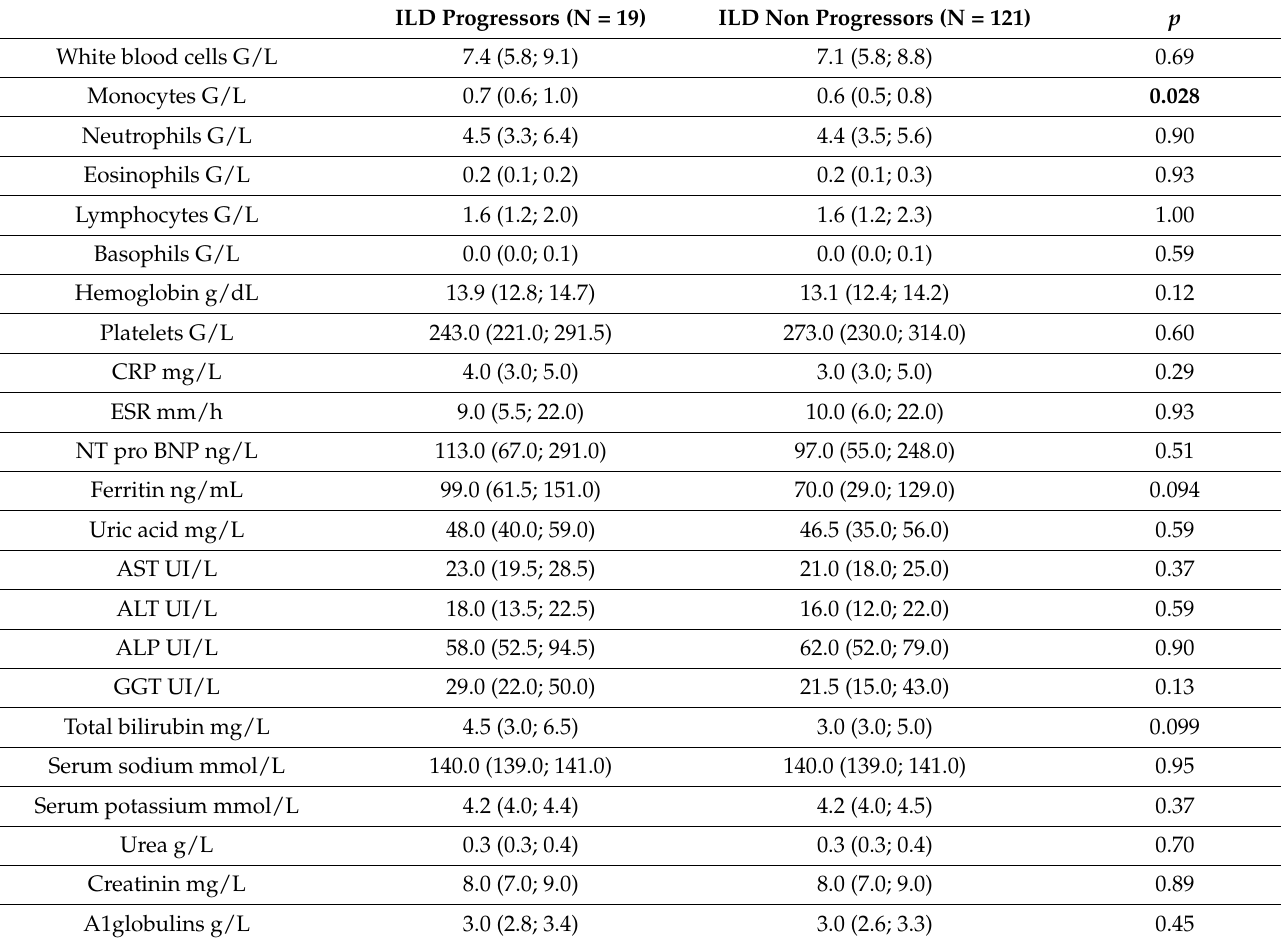
Table 3. Comparison of routine laboratory parameters between ILD progressors and non